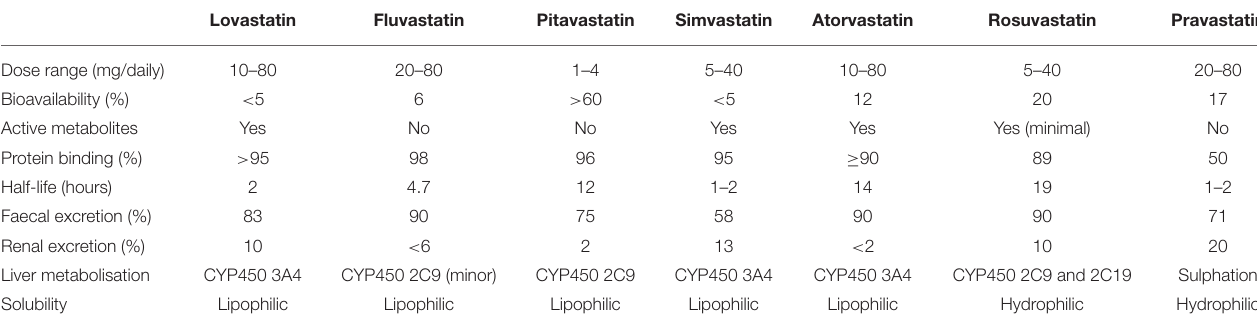
TABLE 1 | Main characteristics of the different statins available in clinical practise. Lovastatin Fluvastatin Pitavastatin Simvastatin Atorvastatin Rosuvastatin